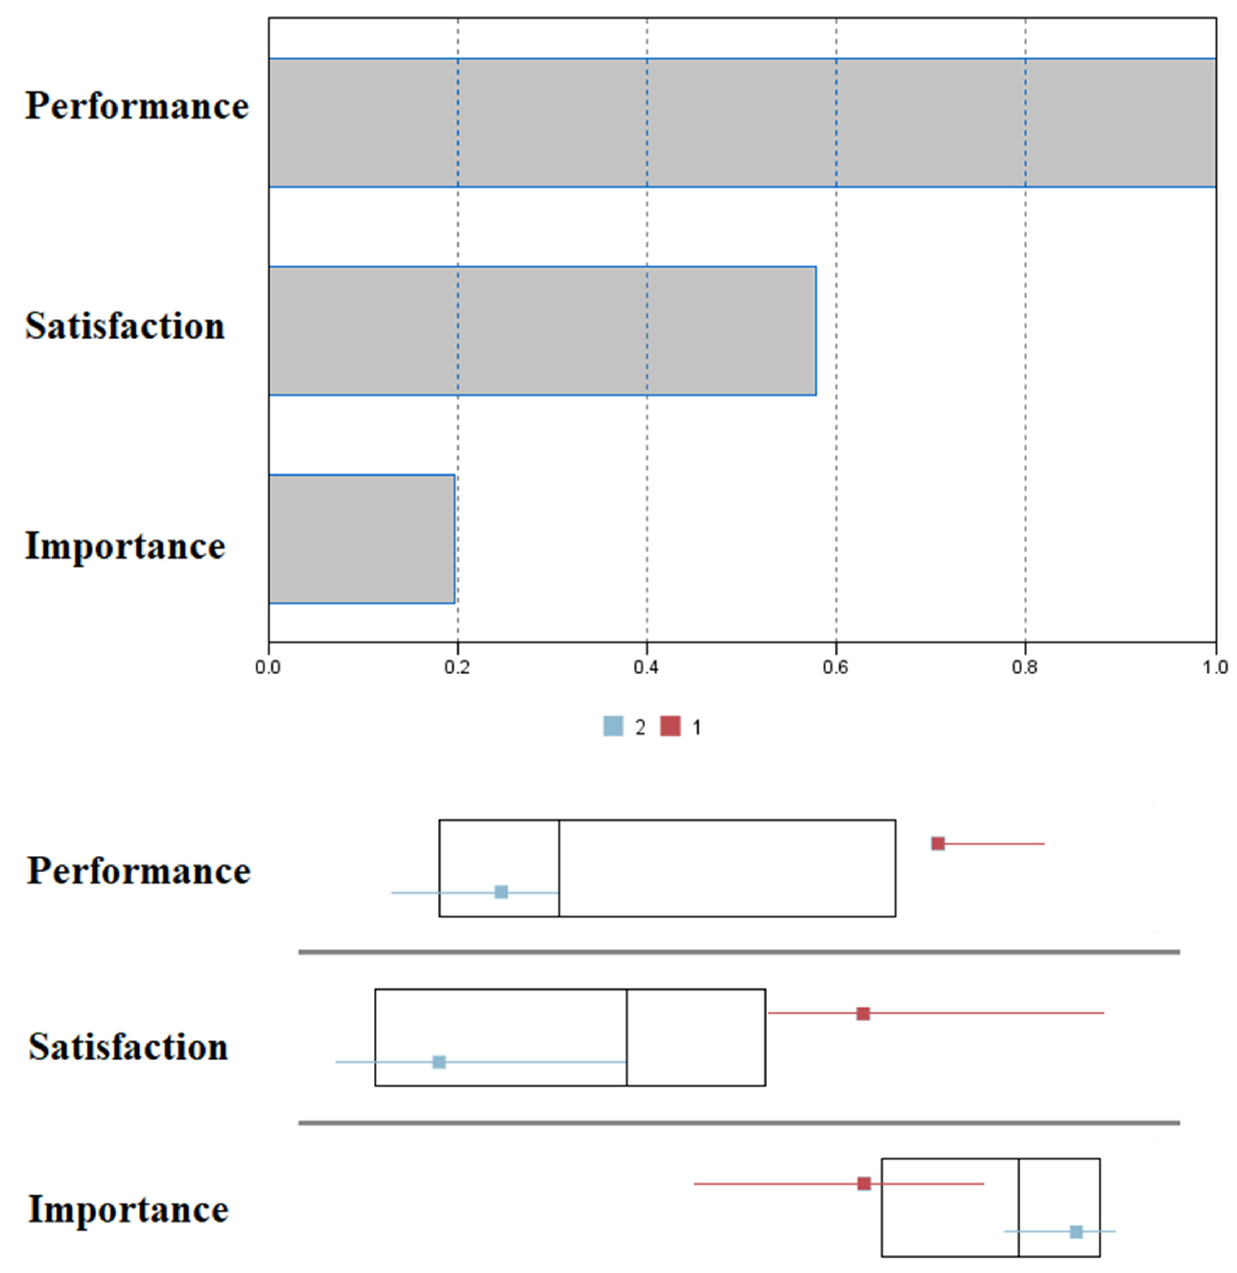
Figure 2. Box plots on cluster groups ( bottom ) and the importance of the predictors ( top ). Lastly, the proposed two-stage cluster analysis was replicated with a hierarchical cluster, as depicted in Figure 3. The structure is presented in a tree diagram format, which is chosen to help illustrate the groupings of the participants. Two large groups are presented, consistent with the previous analysis, except for two subjects, where differences in roles can be